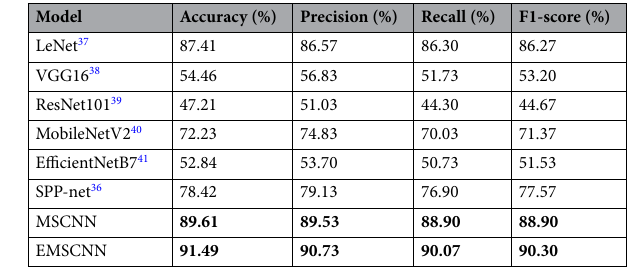
Table 5. Model classification results.